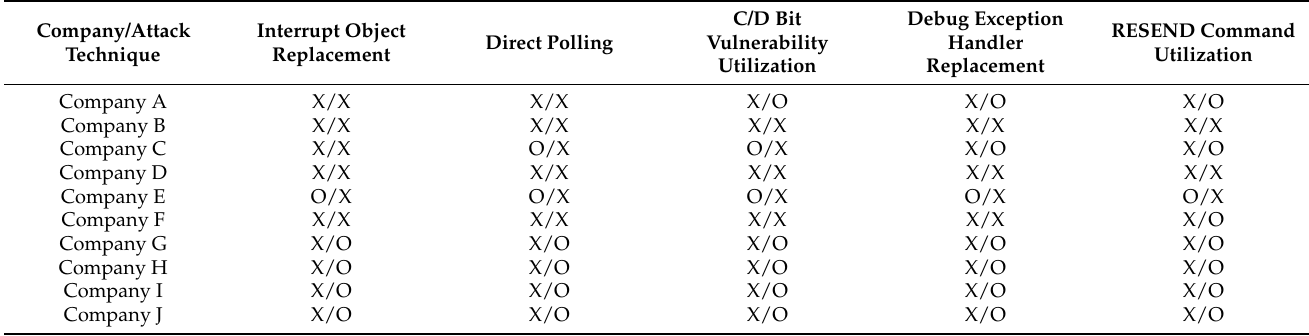
Table 6. Detection results of anti-virus